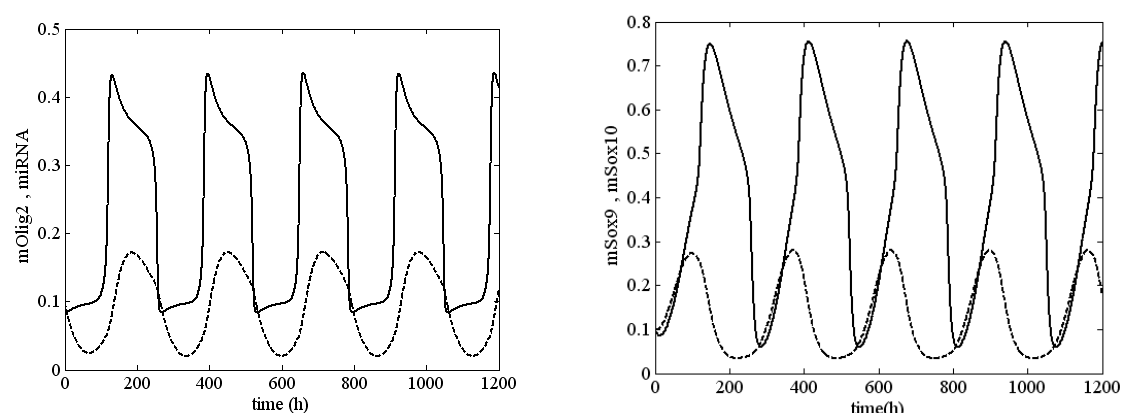
Figure A2. Various stable solutions for mOlig2 (solid line), miRNA, mSox9 and mSox10 (solid line) arising from system (1) when I 1 = I 2 = 0 and k 2 = 0.4762 (black lines); k 2 = 0.04762 (red line), and k 2 = 0.95 (blue line).